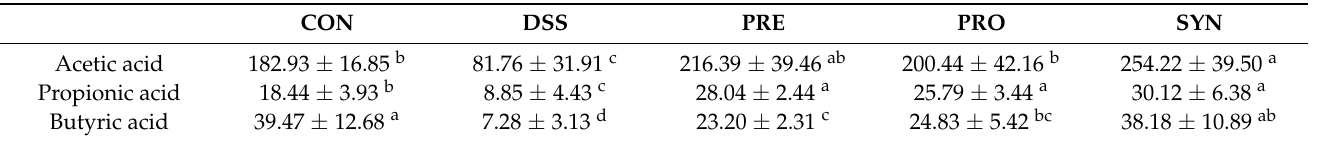
Table 2. Effect of PRE, PRO, and SYN on concentration of short-chain fatty acids (SCFAs) concentra- tion in DSS-induced mice fecal (Unit: